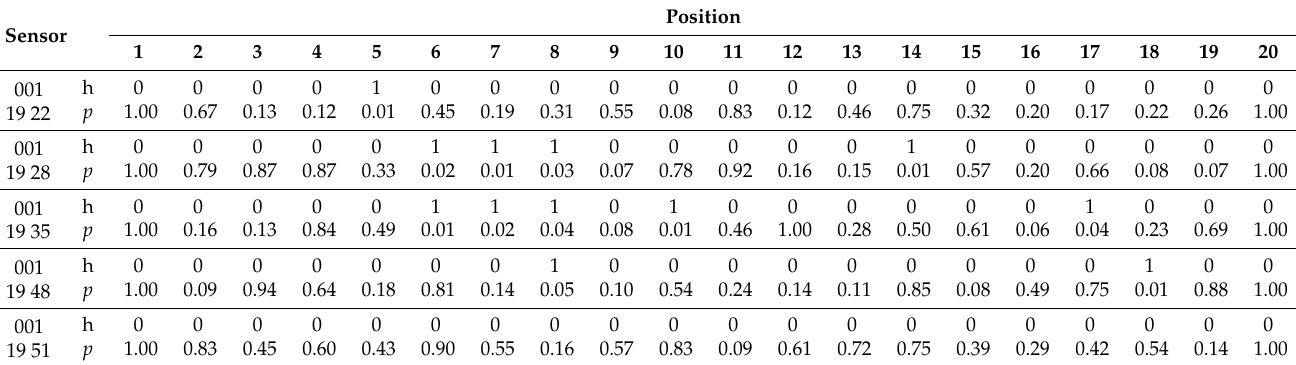
Table 6. Null hypothesis results (h) and p values for the two-sample t -test of Equal Means, at the 5% significance level, in the forward and backward